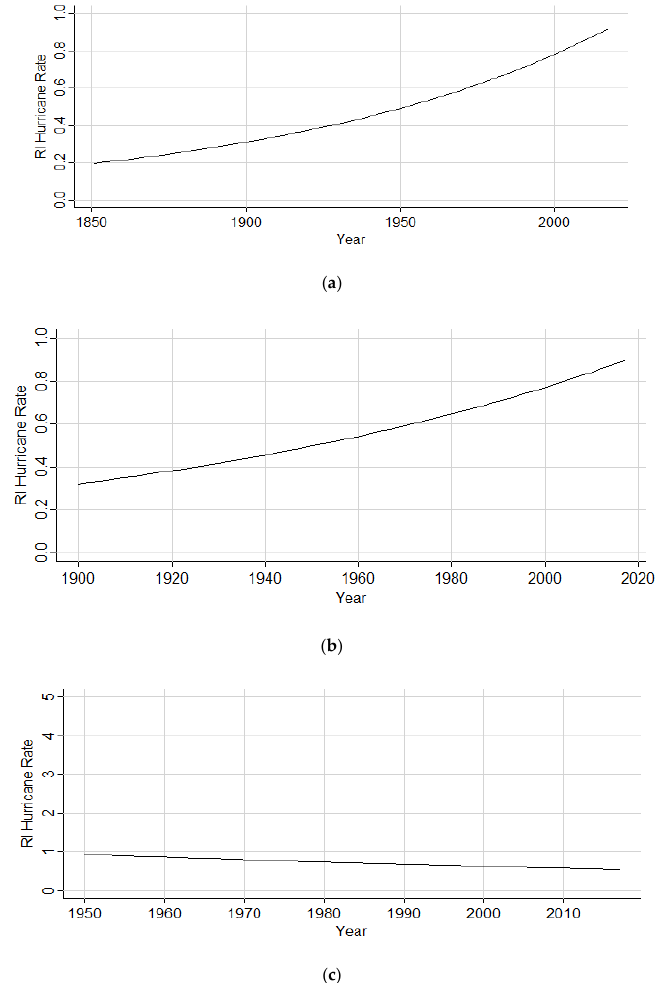
Figure 9. Incidence rate ratios of RI storms originating within the Gulf of Mexico sub-basin over time described by the Poisson regression model ( a ) between 1851–2017, ( b ) depicting 1900–2017, and ( c ) 1950–2017. Table 7. Coe ffi cient estimates, p -values, and chi-square p -values on the residual deviance for RI storms originating within the Gulf of Mexico sub-basin. Table 8. Coefficient estimates, p-values, and chi-square p-values on the residual deviance for RI storms initiating their first cycle of RI within the Gulf of Mexico sub-basin.